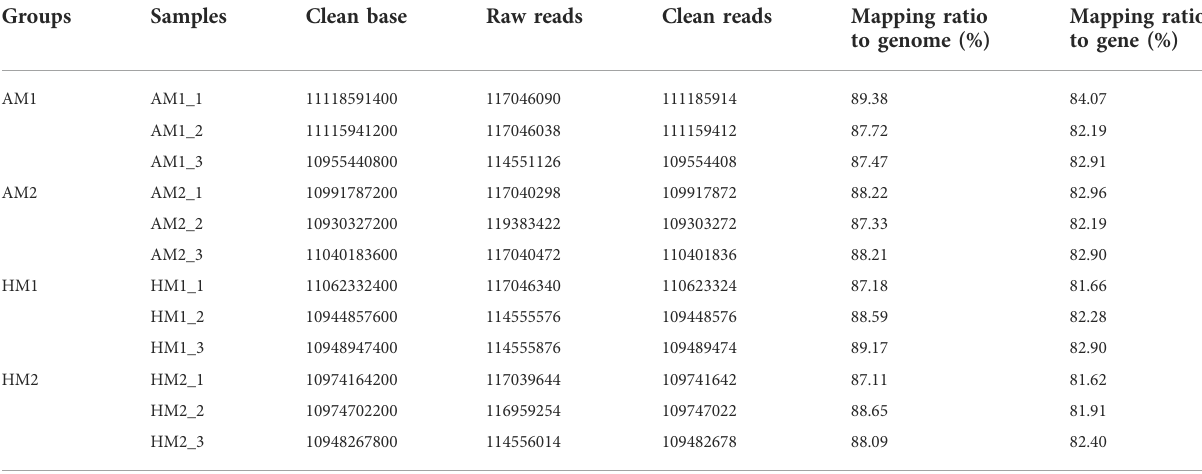
TABLE 2 Statistics of total reads and mapping ratio to reference genome.